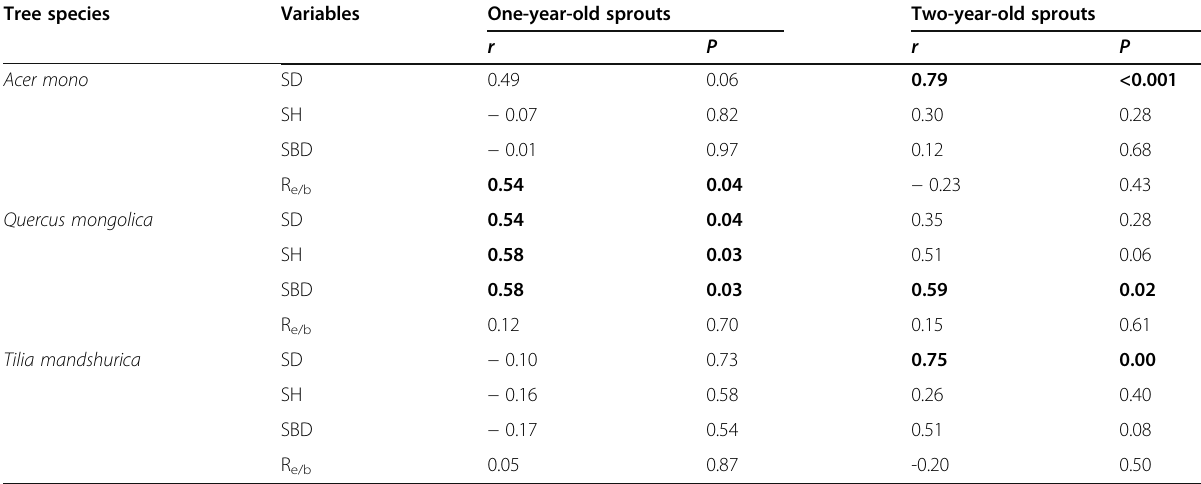
Table 3 Relationships between stump diameter and sprout density/growth/survival in both two growing seasons Tree